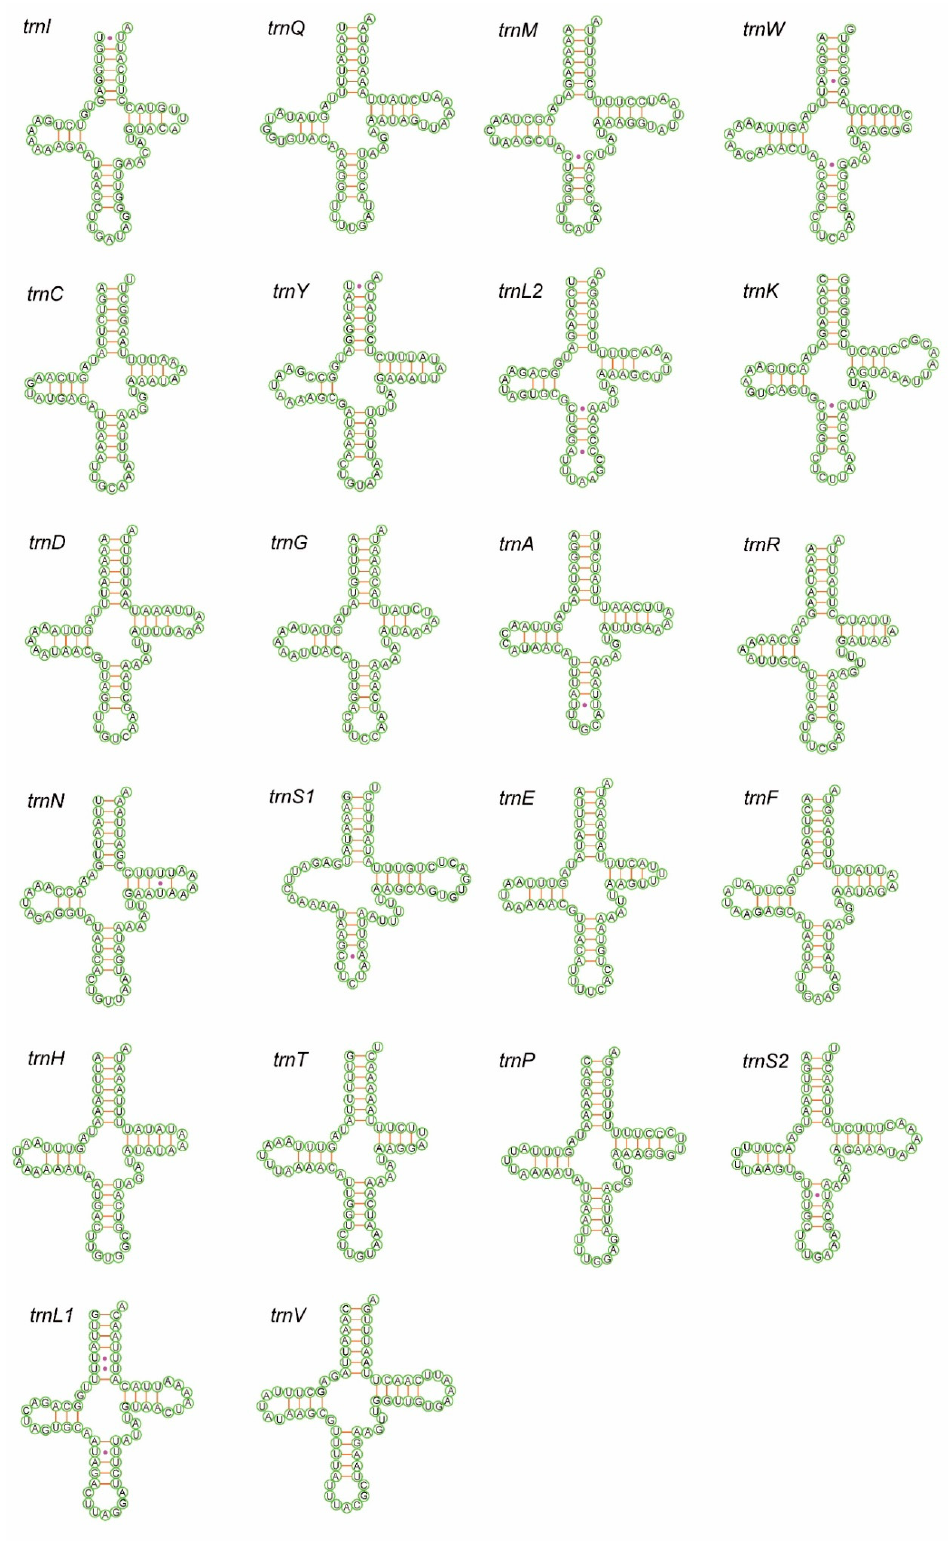
Figure 4. Inferred secondary structure for the tRNAs of X. variegatus .